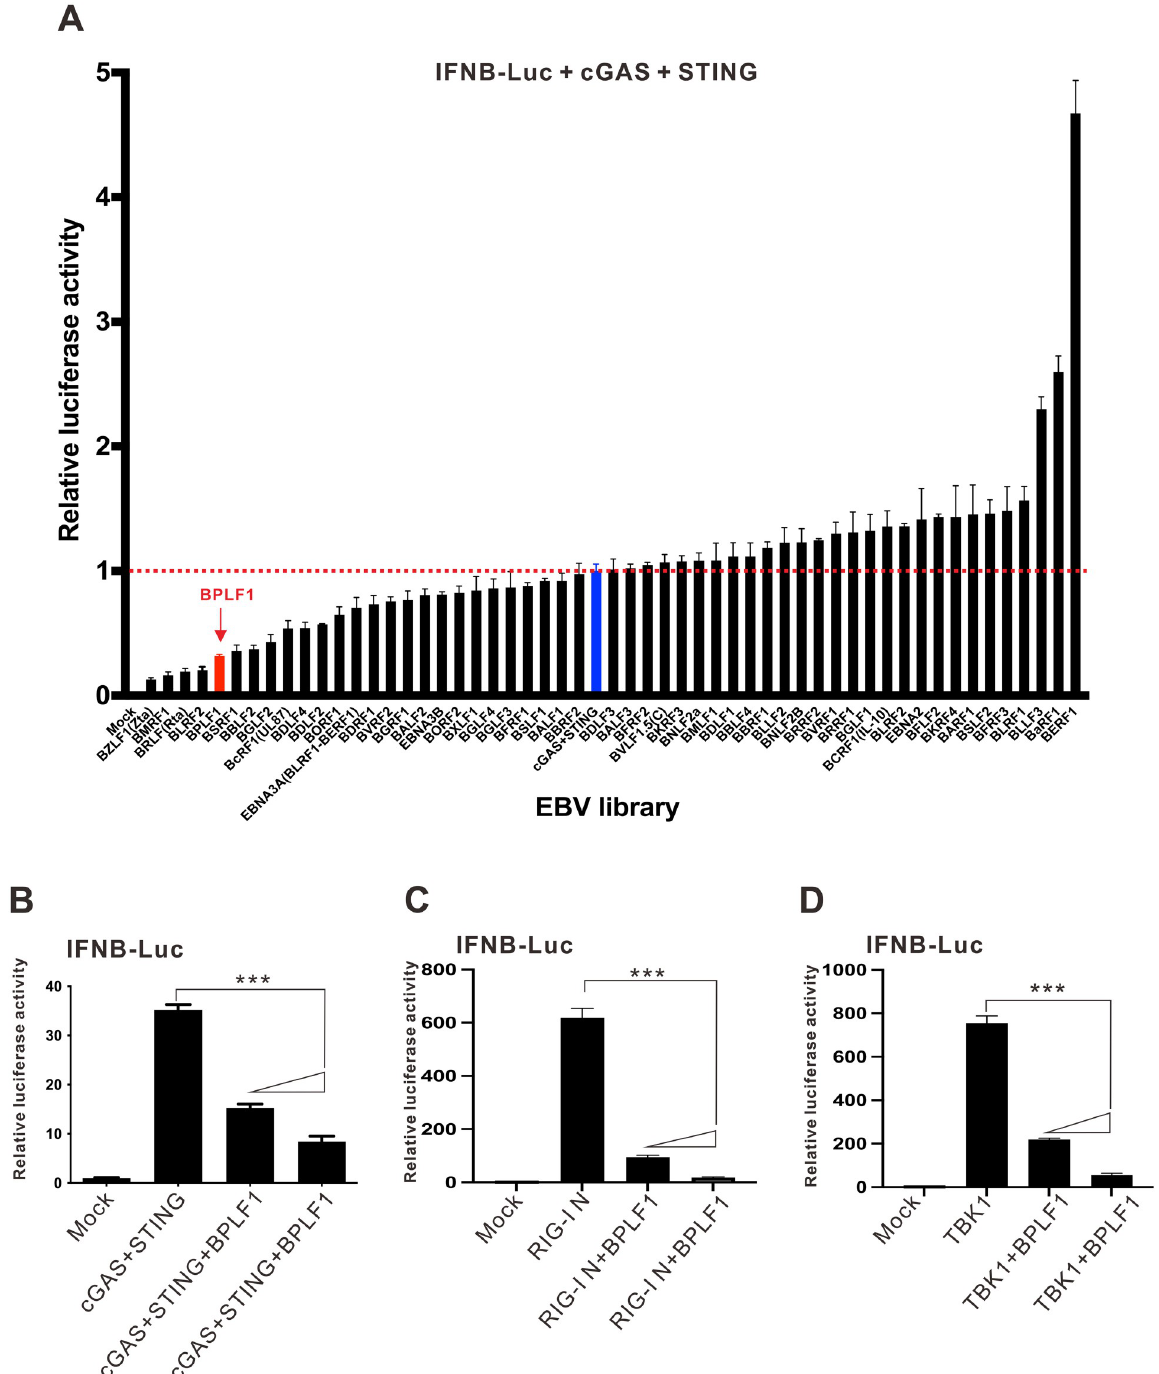
Fig 1. BPLF1 is an IFN antagonist. (A) Functional screening for IFN- β antagonists. HEK293 cells were transfected with a Firefly luciferase reporter plasmid driven by IFN- β -promoter (IFNB-Luc), a control Renilla luciferase reporter plasmid driven by thymidine kinase promoter (TK-Luc) serving to normalize for transfection efficiency, the plasmids for EBV protein expression library, together with cGAS and STING expression plasmids. Cells were harvested 24 hours post-transfection for dual-luciferase assay. The mean values of three biological replicates (n = 3) were represented by the bars and their respective standard deviations were depicted as the error bars. (B-D) BPLF1 inhibits cGAS-STING-, RIG-I- and TBK1-induced IFN β -promoter activation. HEK293 cells were transfected with IFNB-Luc, TK-Luc, and increasing doses of BPLF1 expression plasmid. IFNB-Luc reporter expression was stimulated with expression plasmids for cGAS + STING (B), RIG-I N (C) and TBK1 (D). Cells were harvested 24 hours post-transfection for dual-luciferase assay. The mean values of three biological replicates (n = 3)